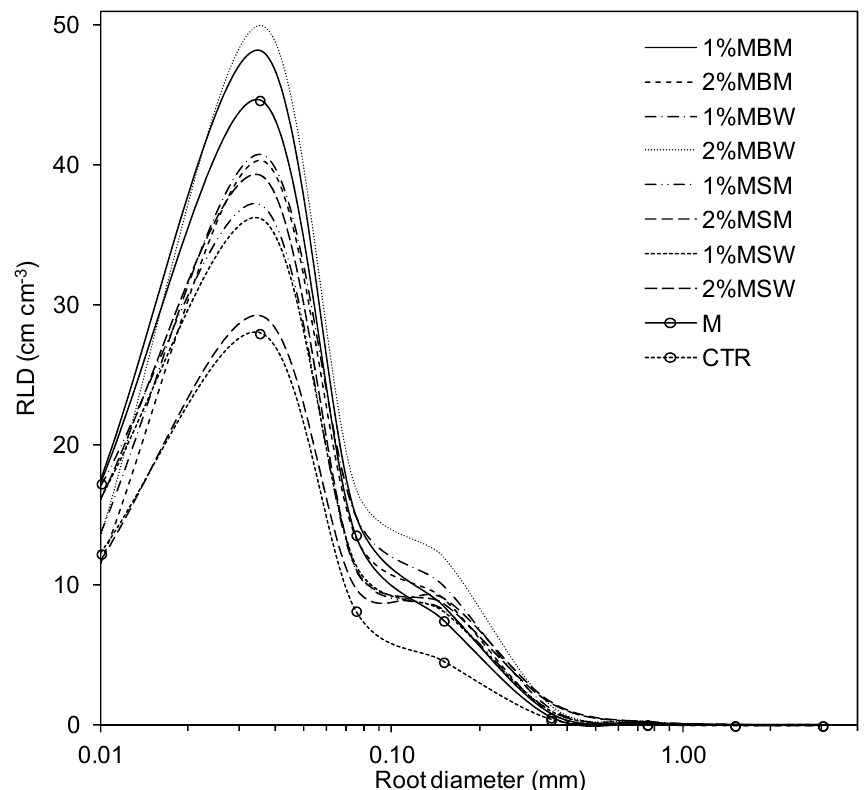
Figure 3. Root length density (RLD) distribution at the di ff erent root diameter values for treatments with di ff erent soil organic amendments. Treatments: wheat straw (MSW), wheat biochar (MBW), Miscanthus straw (MSM) and Miscanthus biochar (MBM), without organic amendments (M) and control treatment (CTR), without organic amendments and mineral fertilization.